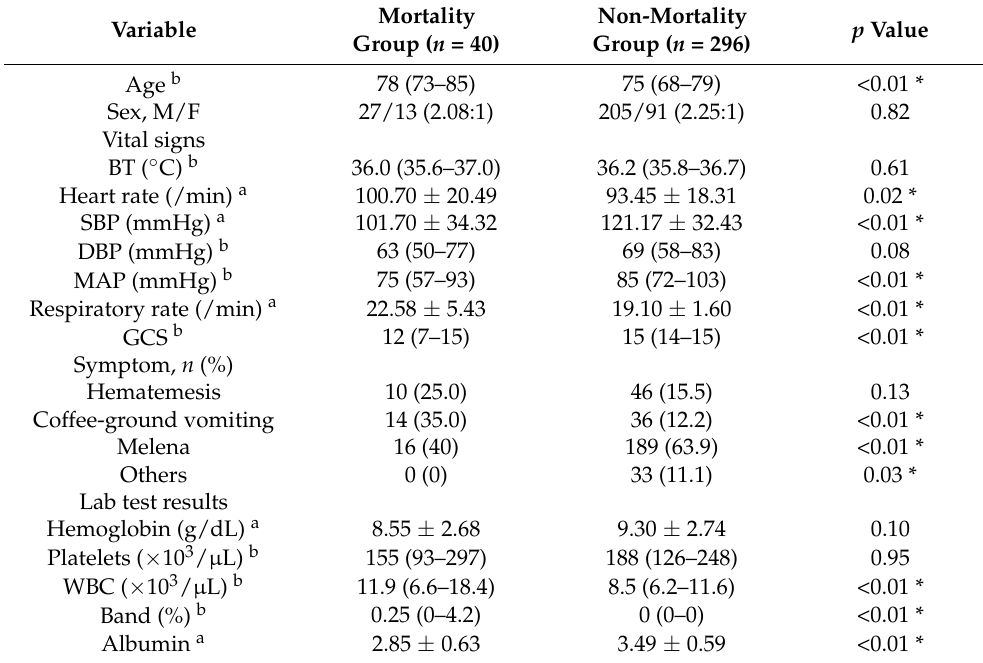
Table 5. Comparisons of baseline characteristics of the patients according to in-hospital mortality.